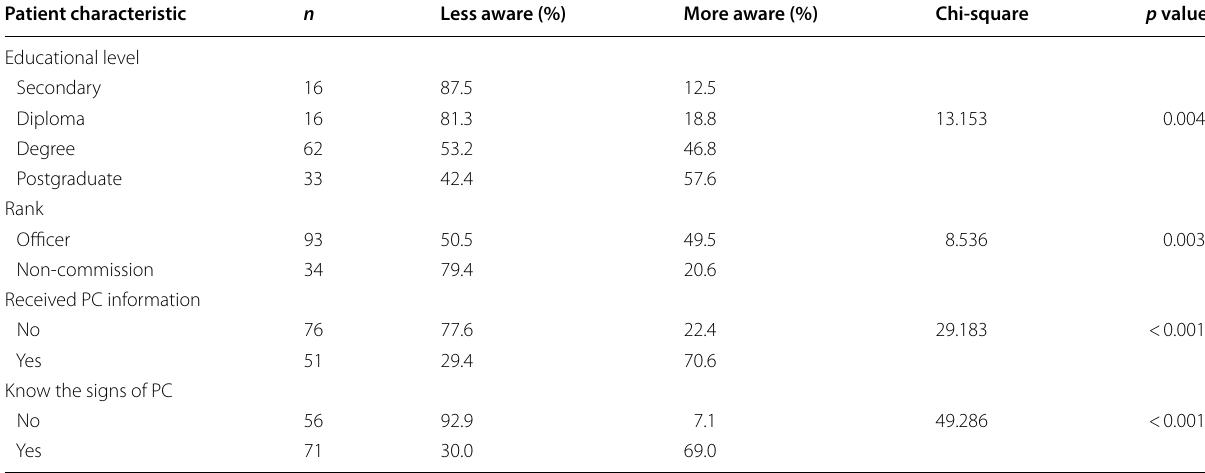
Table 4 Cross-tabulation of respondents’ characteristics and awareness of PC Patient characteristic